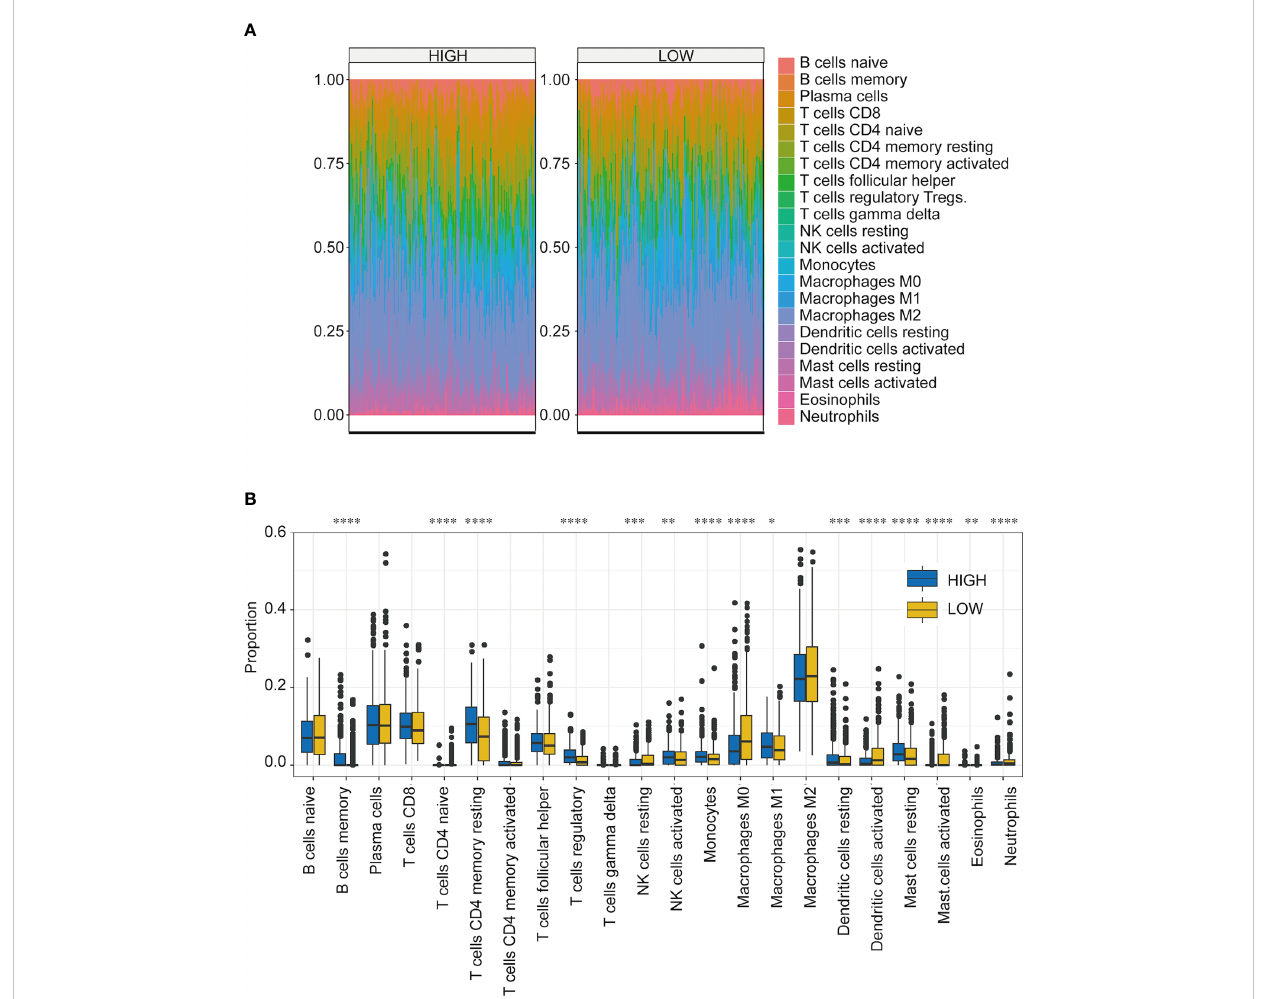
FIGURE 6 Immune microenvironment analysis of NSCLC in high- and low-score groups. (A) Proportion of in fi ltrating immune cells among the 22 groups with high- and low-TF scores. Different colors represent the cell types. (B) In fi ltration ratios of different immune cell types with high- and low-TFs score. * p < 0.05, ** p < 0.01, *** p < 0.001, **** p < 0.0001. Student ’ s